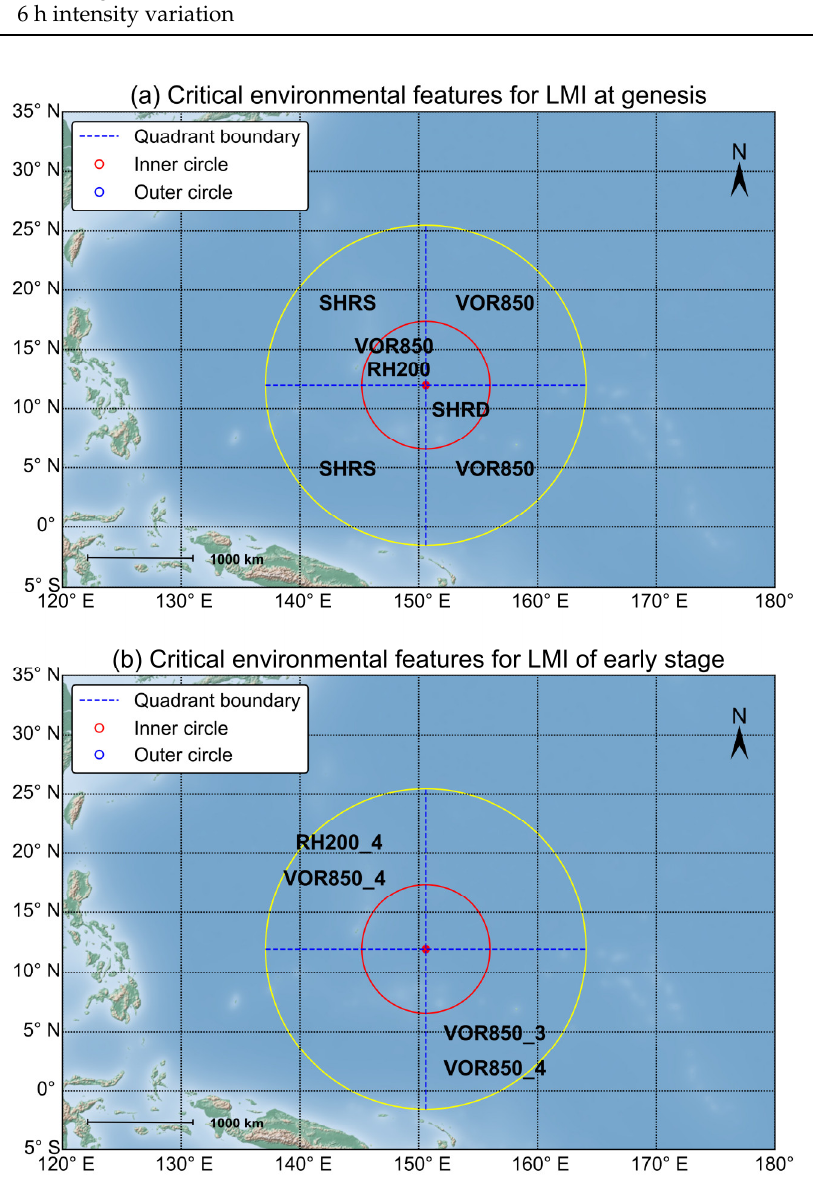
Figure 14. Critical environmental features and their key intervals and quadrants. The classification model based on the AdaBoost algorithm in step 1 had an accuracy of 0.7479 and an F1-score of 0.8387 on the testing set, implying that LMI is related to the